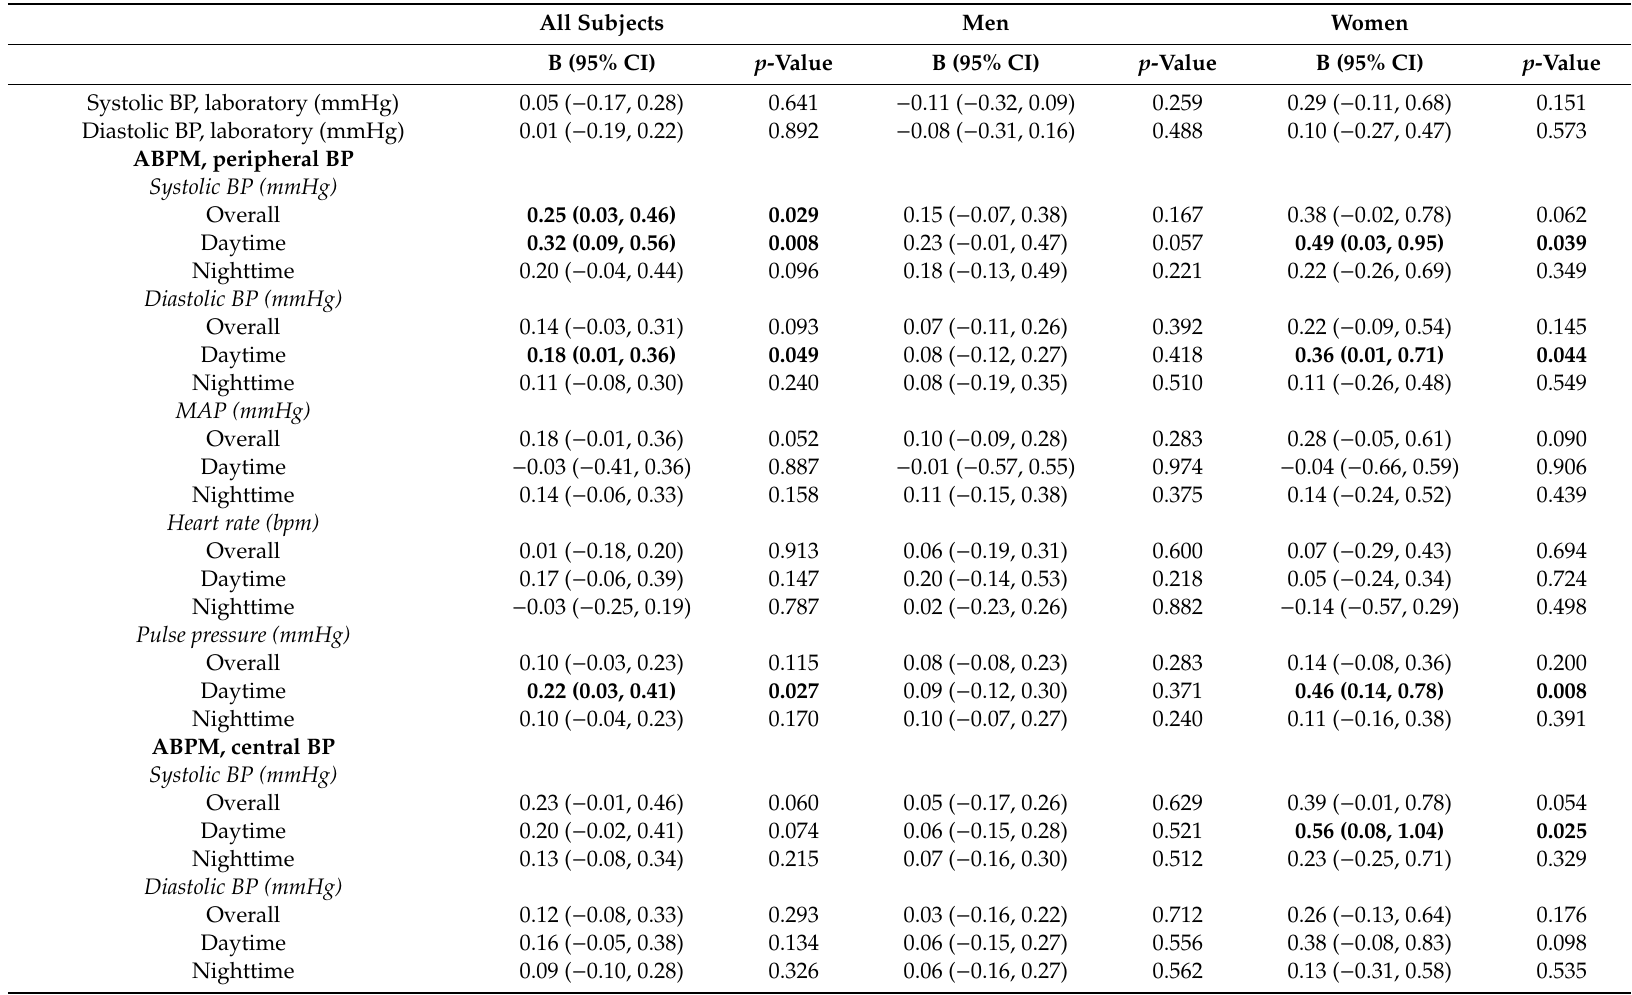
Table 4. Multivariable analyses of the association of ultra-processed food (UPF) consumption, blood pressure (BP), and vascular function, adjusted for age, sex and